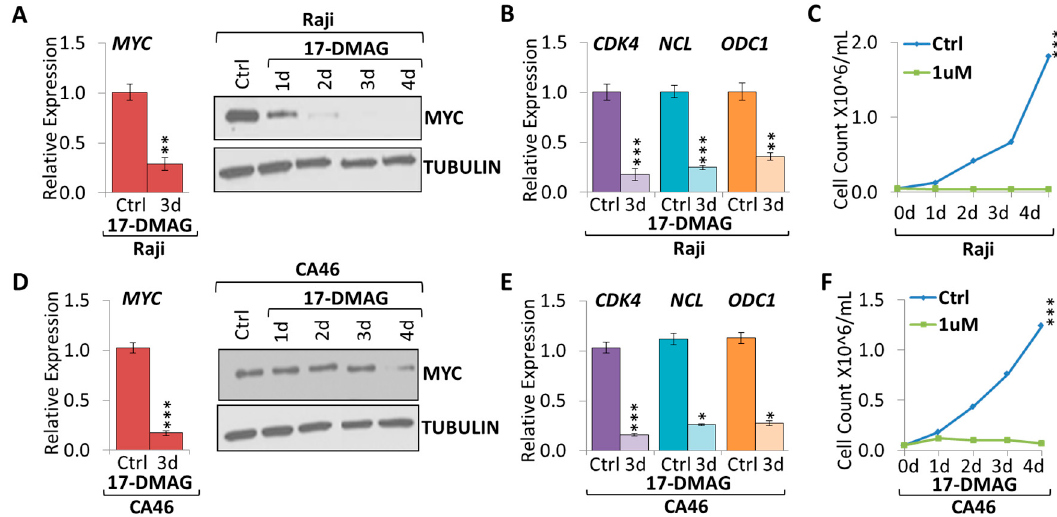
Figure 3. 17-DMAG treatment downregulates MYC expression in Burkitt lymphoma. RT-qPCR and WB of MYC expression upon 1 µM 17-DMAG treatment over the course of four days in ( A ) Raji and ( D ) CA46 cell lines. RT-qPCR of canonical MYC target genes: CDK4 , NCL , and ODC1 in ( B ) Raji and ( E ) CA46 cell lines upon three days treatment of 1 µM 17-DMAG compared to untreated control.